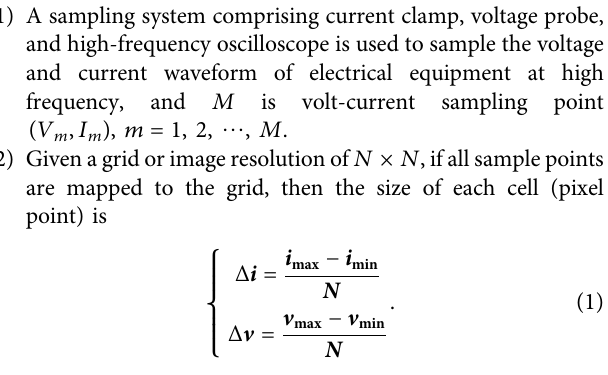
FIGURE 1 | Binary V-I trajectory mapping for a fl uorescent